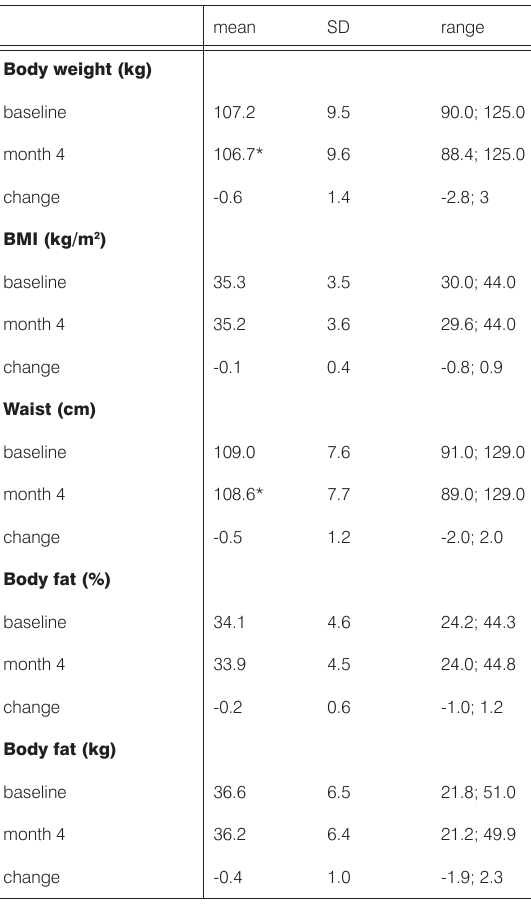
Table 1. Changes in anthropometric parameters, the orlistat group (n = 52) mean SD Range Body weight (kg)